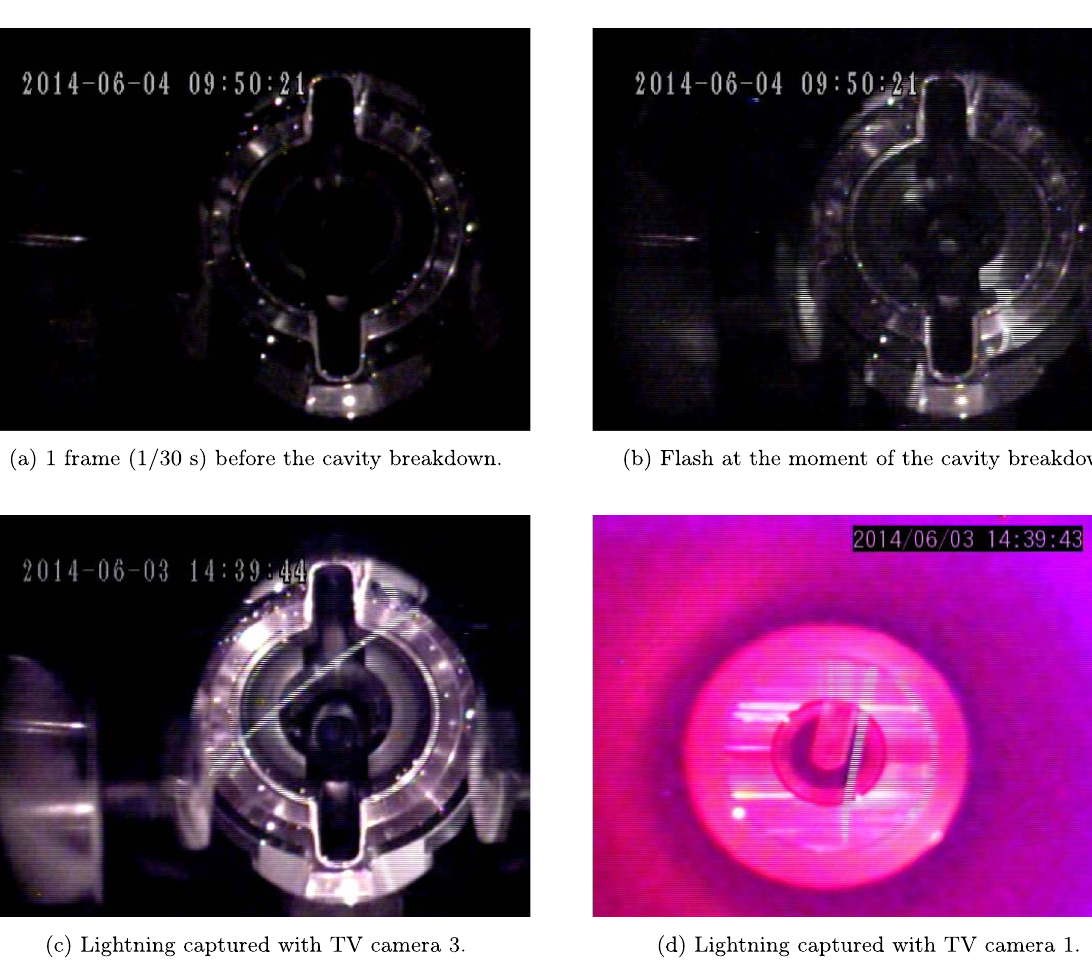
FIG. 16. Examples of non-spot-type breakdown events. (a) and (b) Cavity breakdown event at V c ¼ 0 . 76 MV accompanied by a flash. This event is included in the “ Non-spot-type flash ” column in Table IV. (c) and (d) Snapshots 2 = 30 s before a cavity breakdown at V ¼ 0 . 90 MV accompanied only by lightning. No other phenomena were observed. This event is included in the “ Non-spot-type c lightning only ” column in Table